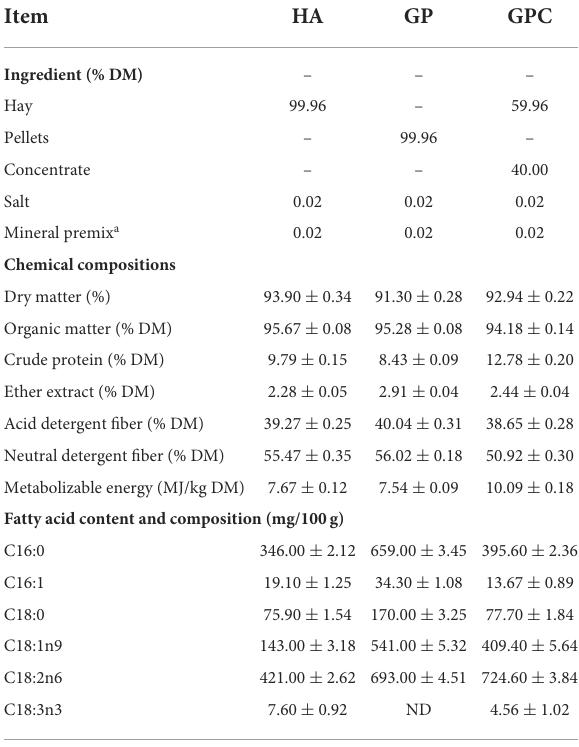
TABLE 1 Ingredients and chemical composition of the experimental